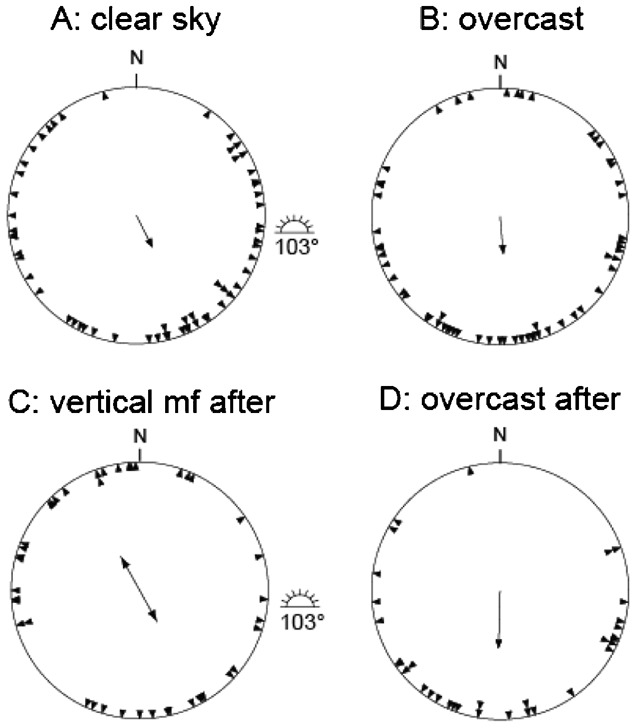
Results from our outdoor orientation cage experiments with juvenile dunnocks, Prunella modularis, at Stensoffa Ecological Field Station in South Sweden during autumn migration.Given is the mean angle of orientation (α) as indicated by a vector for different experimental conditions: (A) clear sky, (B) overcast sky, (C) exposure to clear skies without magnetic cues at vertical magnetic field vector, and (D) simulated overcast as a control after cue-conflict exposure. The azimuth to the Sun (¤) in the middle of the test hour is given. The mean orientation for each individual bird is shown as a triangle within the circle. Circular statistics for each circular distribution is given in Table 2.